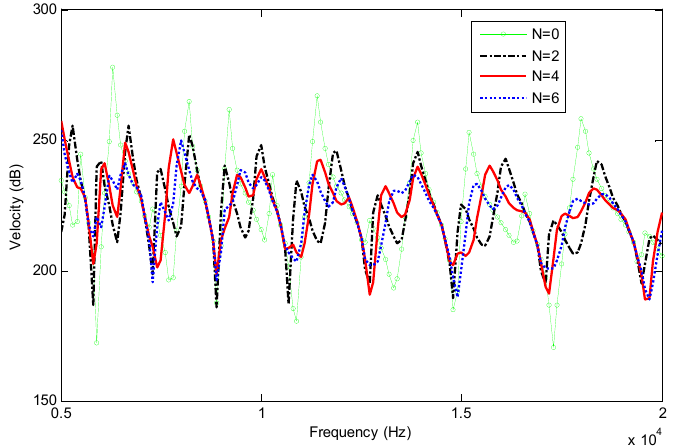
Materials 2019 , 12 , x FOR PEER REVIEW Figure 2. Frequency responses of the beams with FGP ends for di ff erent power law index (Euler-Bernoulli beam). Figure 2. Frequency responses of the beams with FGP ends for different power law index (Euler- Bernoulli beam).